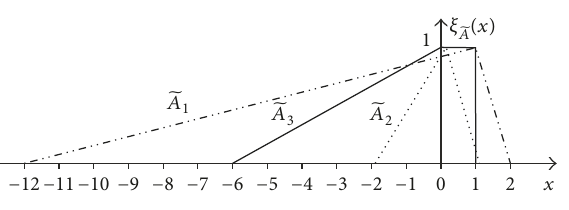
̃𝐴 ̃𝐴 ̃𝐴 1 , 2 , and 3 in Example 20. ̃𝐴 = (−12, 1, 2) and ̃𝐴 = (−23/12, 1/12, 1 2